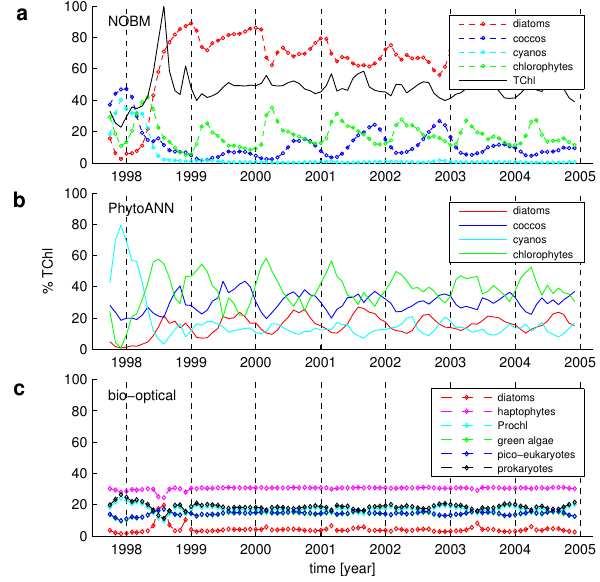
Fig. 9. October 1997–December 2004 time series of the percentage contribution to total Chl of four phyto-PFTs in the EEP from (a) NOBM and (b) PhytoANN, as well as that (c) of six phyto-PFTs from the bio-optical algorithm (Hirata et al., 2013). Additionally, time series of total Chl (normalized to units of percentage contribu- tion) measured by SeaWiFS is included in panel (a) . Variability in total Chl corresponds equally to total Chl in the PhytoANN (which normalizes total phyto-PFT biomass to total SeaWiFS Chl), the bio- optical model Chl and the NOBM (which assimilates satellite